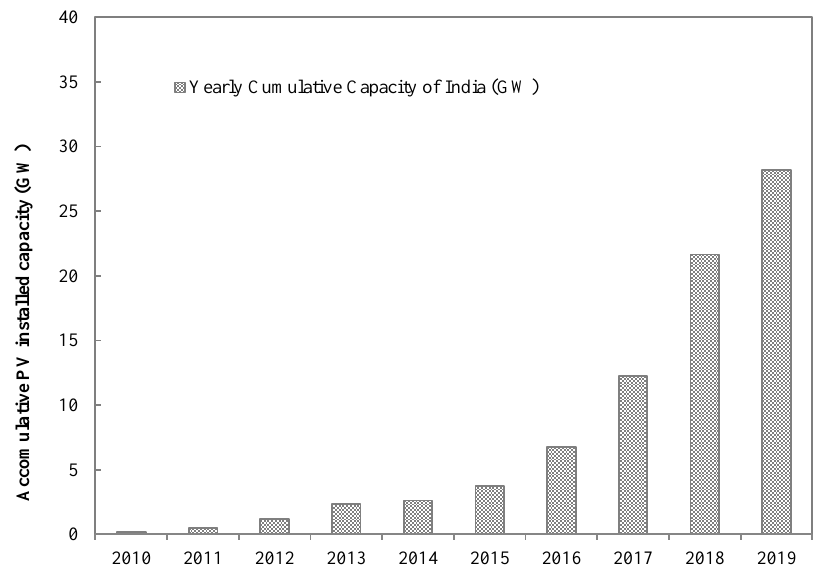
Figure 1. Time series plot of installed photovoltaic capacity of India from 2010 to 2019.